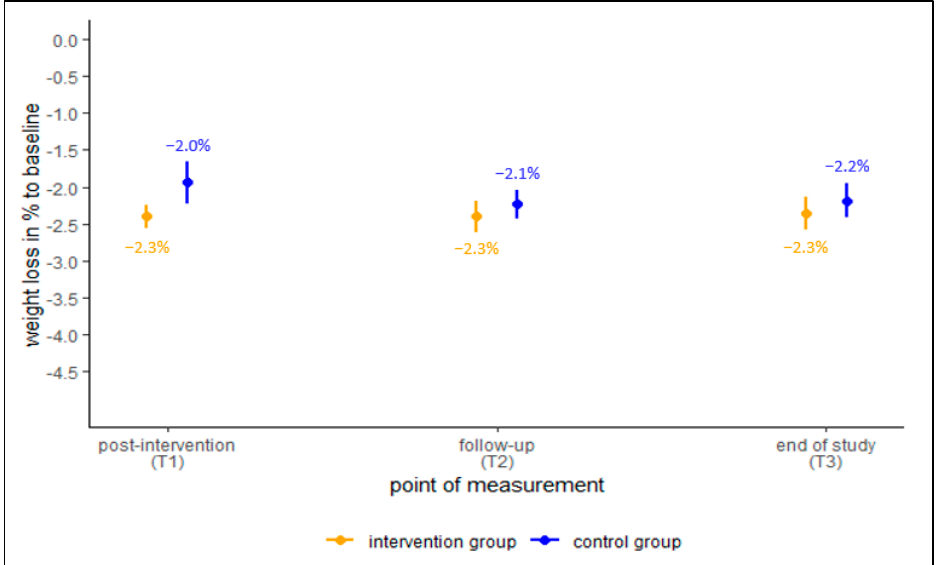
Figure 2. Mean change in weight loss in %, ITT imputed data set, global mean with 95%-confidence intervals.